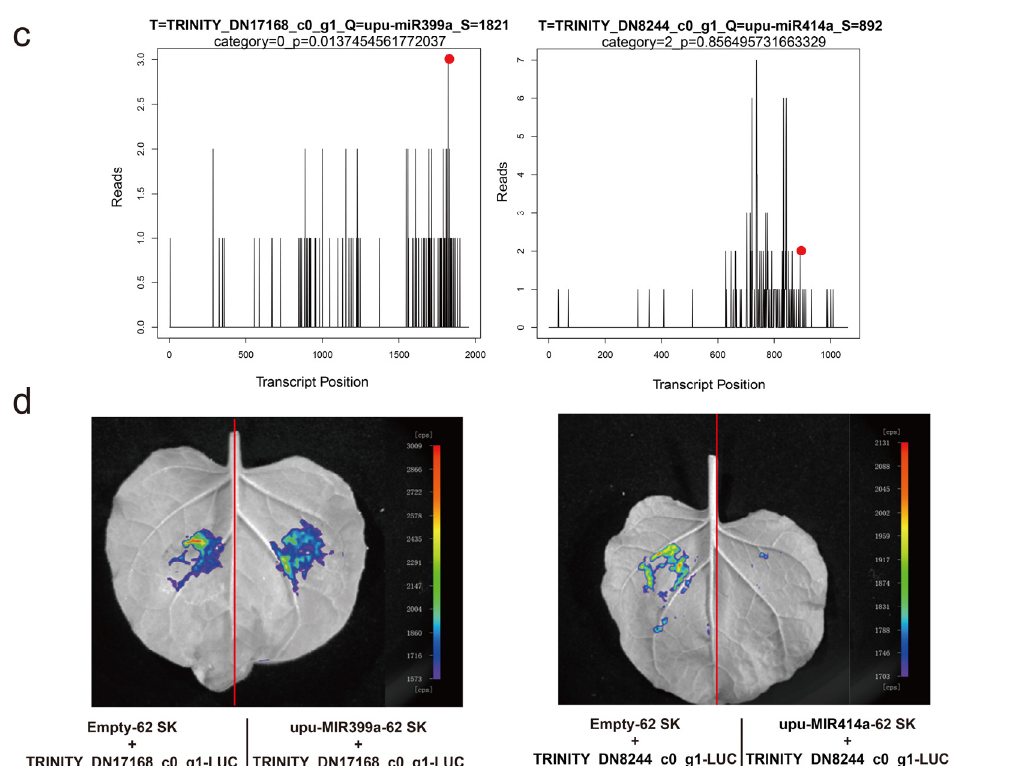
Figure 6. Validation of miRNA cleavage predicted target genes by dual − luciferase assay. ( a ) Se- quence match between upu − miR399a, upu − miR414a, and their predicted targets. The target gene (top) and its corresponding miRNA (bottom) are shown in each alignment. The match is displayed in a joint line, and G: U wobble pairing in a circle. ( b ) Construction of the reporter and effector vectors of a dual − luciferase assay. ( c ) Target plots (t − plots) of miRNA targets confirmed by degradome sequencing. The vertical line with a red point indicates the cleavage site of each transcript. ( d ) Dual − luciferase assay of upu − miR399a − ABCG25 (left panel) and upu − miR414a − GIF (right panel). The left side of the red line is the injection area of the control group, and the right side is the injection area of the experimental group. Different colors mean luciferase activity. Cps, signal counts per second.